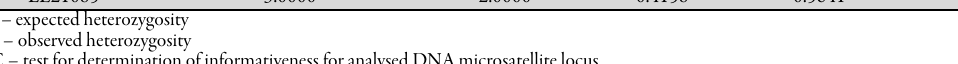
Table 2. Genetic variability and polymorphism of locus LE21085 in the researched tomato varieties Locus Number of genotypes LE21085 3.0000